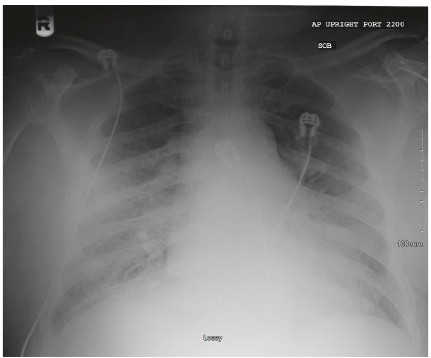
Figure 1: Portable chest X-ray. Minimal cardiomegaly and minimal interstitial pulmonary vascular congestion. Possible small right pleural